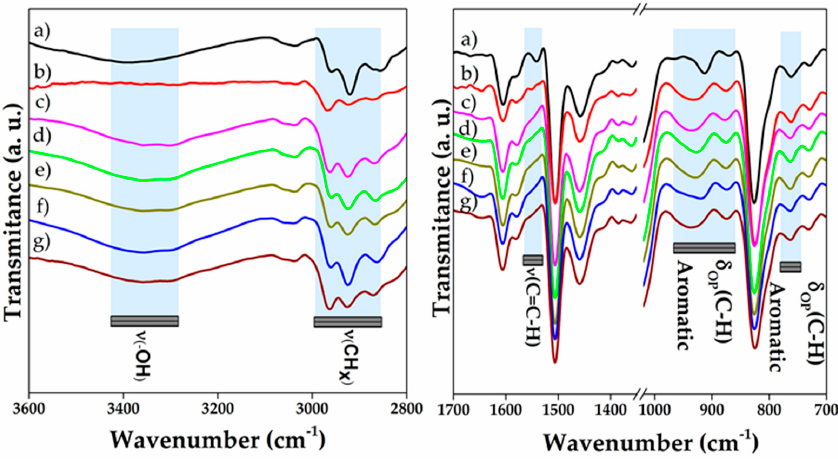
Figure 4. Infrared spectra of multidimensional nanocomposites of: ( a ) Neat epoxy MD; ( b ) MWCNT 0.1 wt % MD; ( c ) O-MWCNT 0.1 wt % MD; ( d ) GO 0.1 wt % MD; ( e ) RGO 0.1 wt % MD; ( f ) MWCNT-RGO 0.1–0.1 wt % MD; and ( g ) O-MWCNT-GO 0.1–0.1 wt % MD.